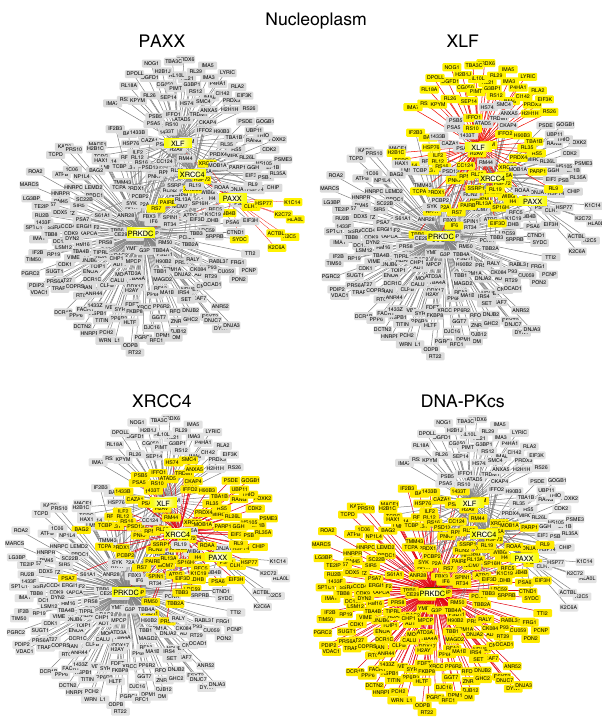
Fig. 2 Comparative Analysis of the Nucleoplasmic Proteomes of XRCC4 Family Proteins. As described in Fig. 1, except the nucleoplasmic fraction was